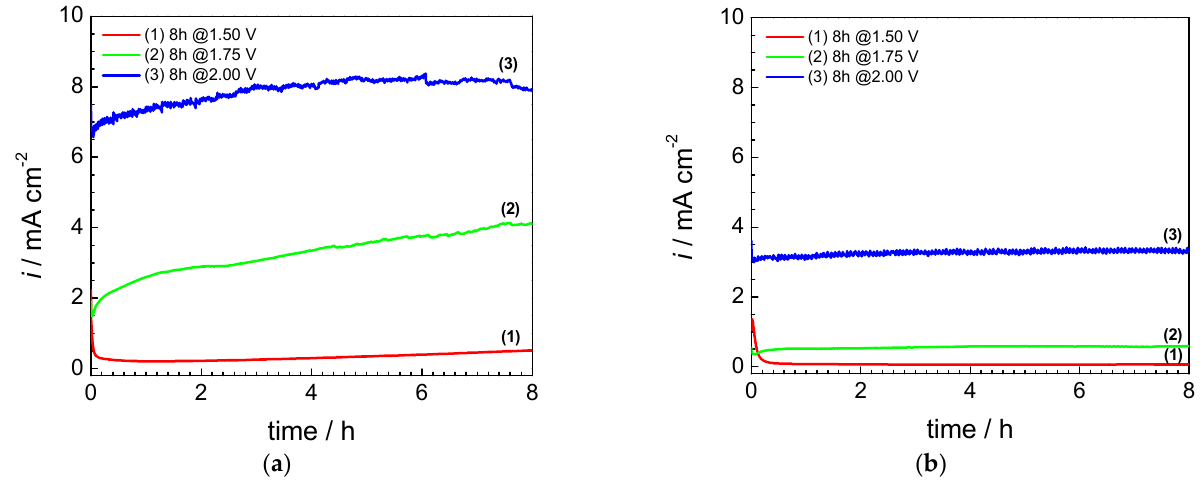
Figure 2. Current transients during PST at different potentials (1.5 V SHE , 1.75 V SHE and 2.0 V SHE ) in 0.1 M Na 2 SO 4 + 0.1 ppm F − 1 (pH = 5): ( a ) AISI 442 steel sample; ( b ) AISI 446 steel sample.